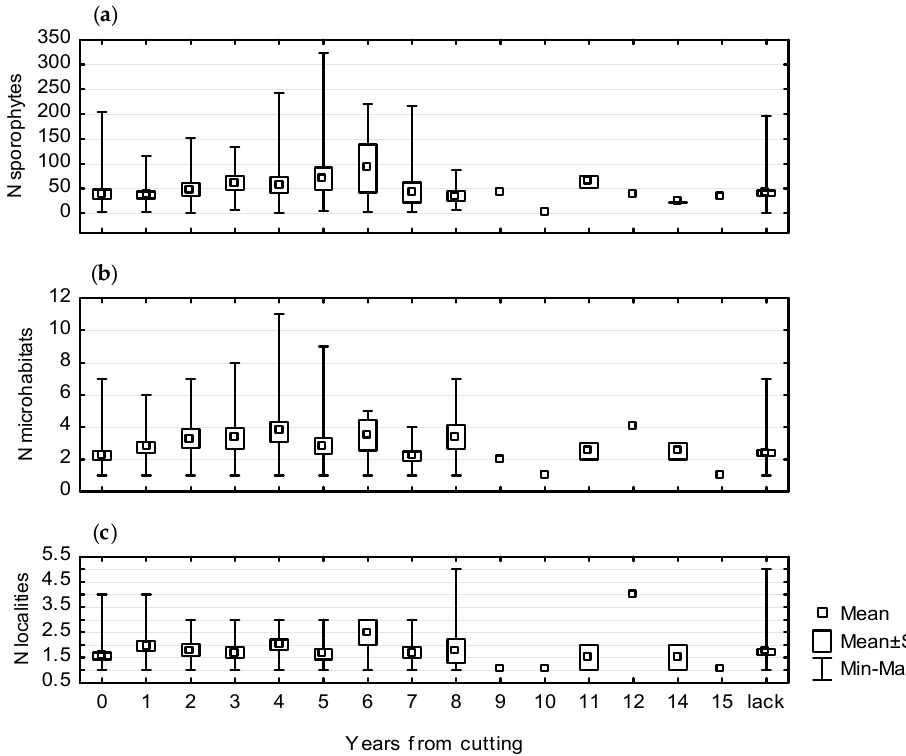
Figure 3. Relationship between the occurrence of Buxbaumia viridis and the time elapsed from the last silvicultural treatment. ( a ) Number of sporophytes as a function of years from cutting. The Kruskal-Wallis test results were as follows: H (df = 15, N = 202) = 12.03537, p = 0.6763. ( b ) Number of microhabitats as a function of years from cutting. The Kruskal-Wallis test results were as follows: H (df = 15, N = 202) = 17.21029, p = 0.3065. ( c ) Number of localities as a function of years from cutting. The Kruskal-Wallis test results were as follows: H (df = 15, N = 202) = 14.95010, p = 0.4550.